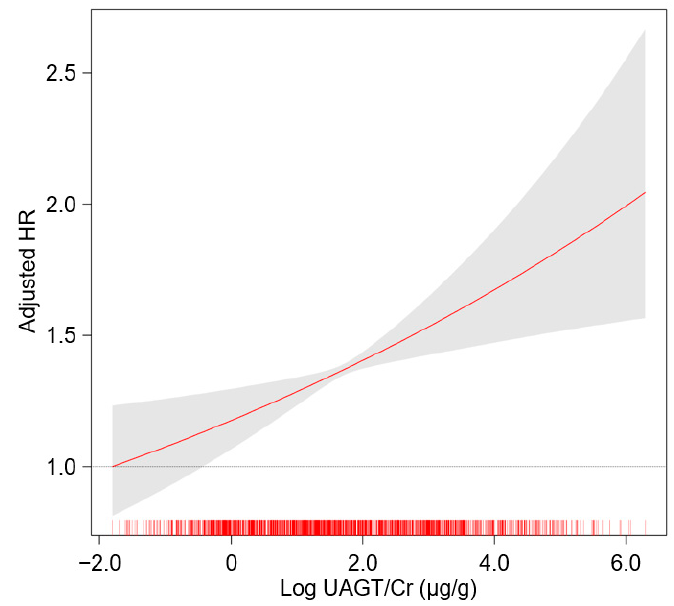
Figure 3. Restricted cubic spline of UAGT/Cr on composite renal event. Adjusted HR of UAGT/Cr as a continuous variable for composite renal event is depicted. The model was adjusted for age, sex, age-adjusted Charlson comorbidity index, primary renal disease, current smoking, medications (ACEi/ARBs, diuretics, number of antihypertensive drugs, statins), BMI, SBP, DBP, hemoglobin, albumin, fasting glucose, total cholesterol, LDL-C, HDL-C, TG, 25(OH) vitamin D, hs-CRP, serum creatinine and spot urine ACR. Abbreviations: HR, hazard ratio; UAGT/Cr, urinary angiotensinogen-to-creatinine ratio.